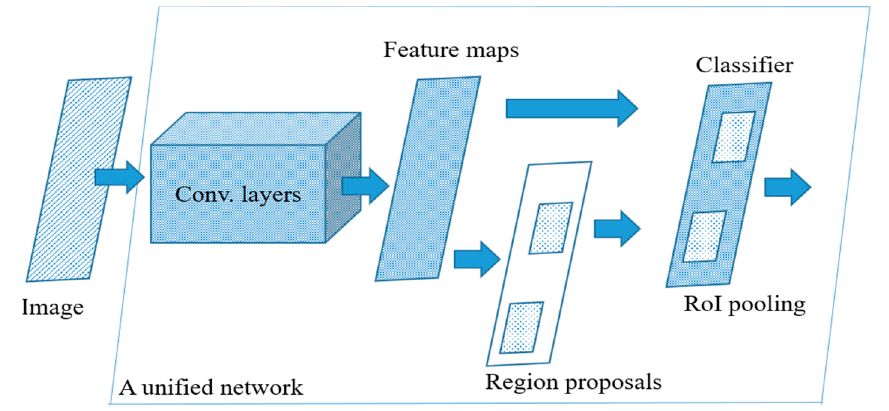
Figure 3. The illustration of the faster region-based convolutional neural network (Faster R-CNN) unified network.